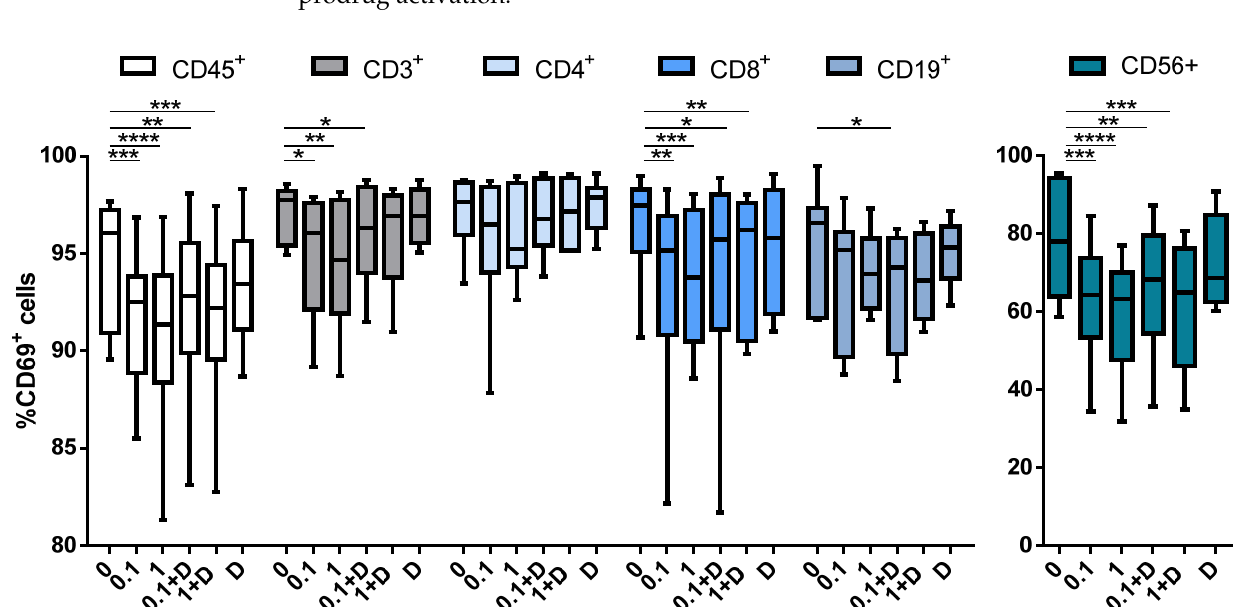
Figure 4. Box plots showing the impact of cladribine on the activation of PBMCs subpopulations. PBMCs were stimulated with PMA plus ionomycin for 4 h with no cladribine (untreated condition), 0.1 µ M or 1 µ M of cladribine, in the presence or absence of 250 µ M deoxycytidine. Activation was represented as the percentage of gated CD45 + , CD3 + , CD4 + , CD8 + , CD19 + and CD56 + that showed positivity for CD69. The gating strategy for this experiment is shown in the Supplementary Figure S3. One-way ANOVA with repeated measures followed by Dunnett’s multiple comparisons test was performed, comparing every mean value to a control mean (0 group). * p -value < 0.05, ** p -value < 0.01, *** p -value < 0.001, **** p -value < 0.0001. ( N = 10). Cladribine concentrations ( µ M) are represented on the x axis. D: deoxycytidine.